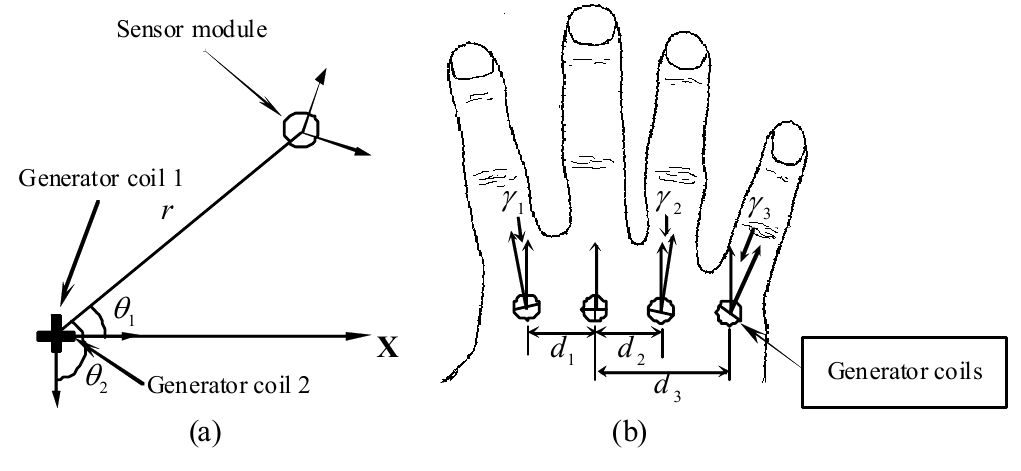
Figure 5. The positions and orientations of: (a) the sensor module and generator coils of one finger; (b) the generator coils of four